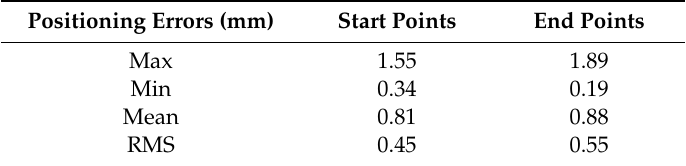
Table 2. Positioning Errors of the navigation system for ACL